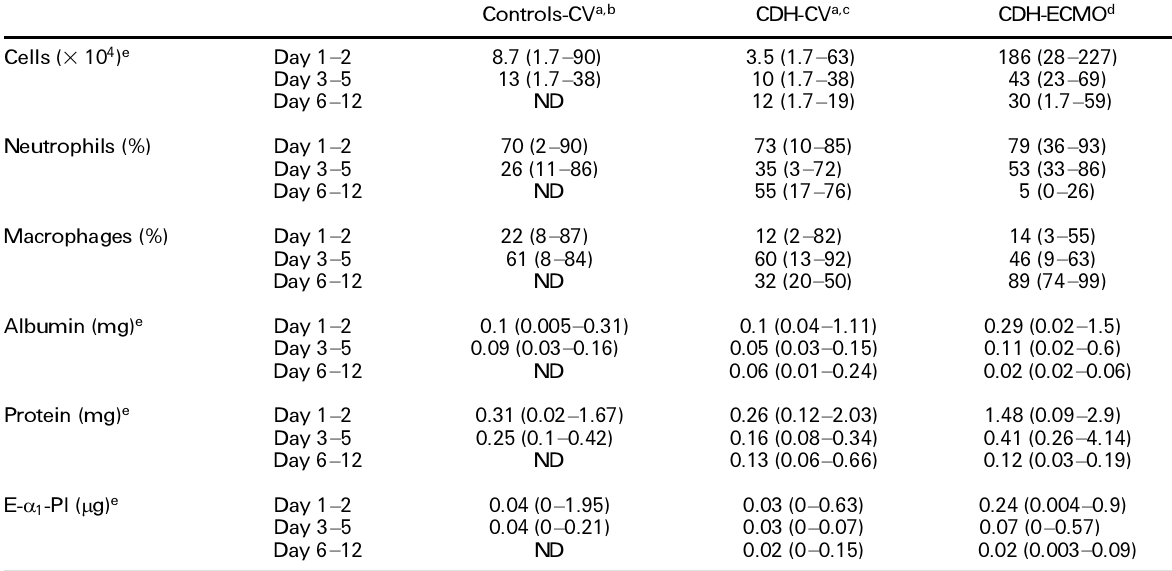
Table 3. Total cell count, cell differentiation, albumin, total protein and elastase- a 1 -proteinase inhibitor complex (E- a 1 -PI) in BAL ¯ uid of ventilated controls and CDH patients, and in CDH patients treated with ECMO Controls-CV